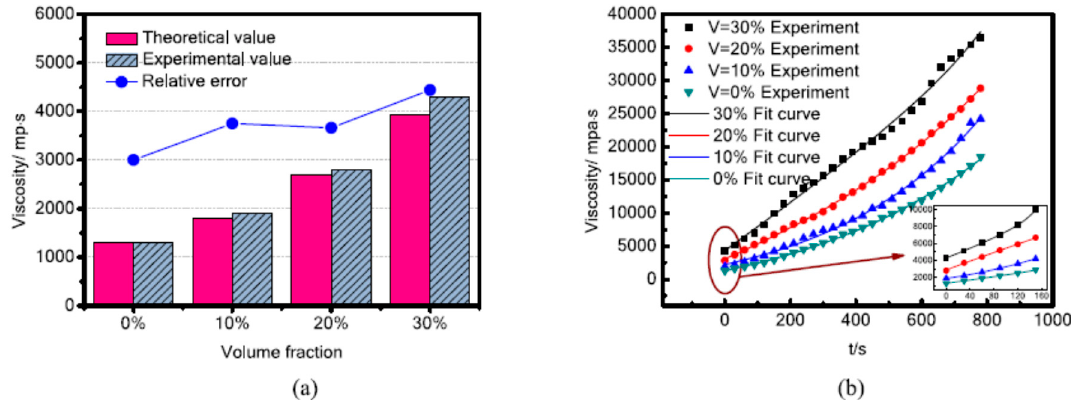
Figure 15. ( a ) The plot of theoretical and experimental values of initial viscosity of MREs containing different volume fractions of magnetic particles. ( b ) Curves of MREs’ viscosity measured during curing [45] (reprinted with permission from Elsevier TM ).